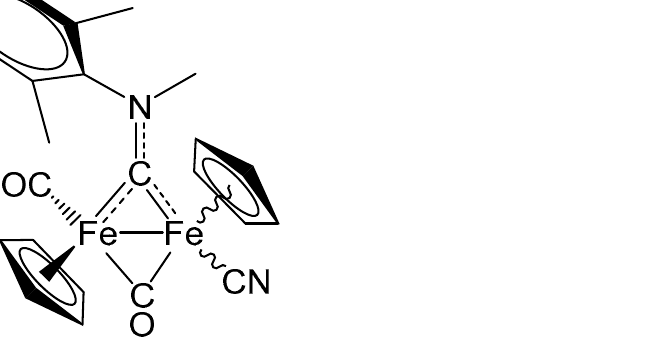
/cm − 1 = 2090 w (C ≡ N), 1959 vs.